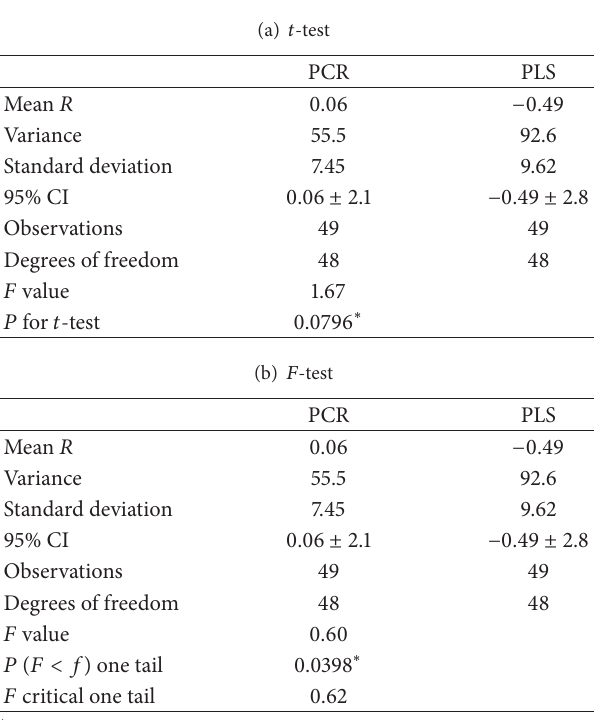
Table 1: Hypothesis testing of (2) through (a) 𝑡 -test and (b) 𝐹 -test.